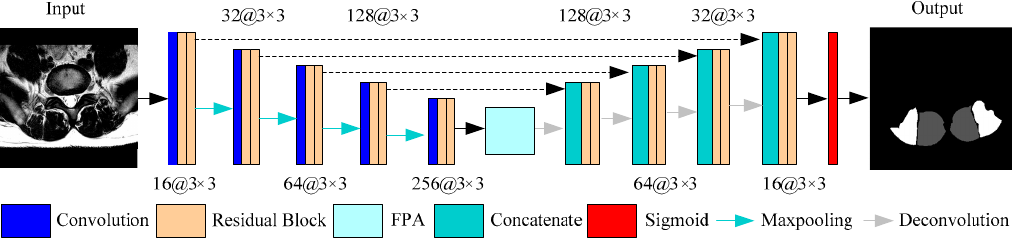
Figure 3. An illustration of the proposed framework for multifidus (MF) and erector spinae (ES) segmentation in MR images.